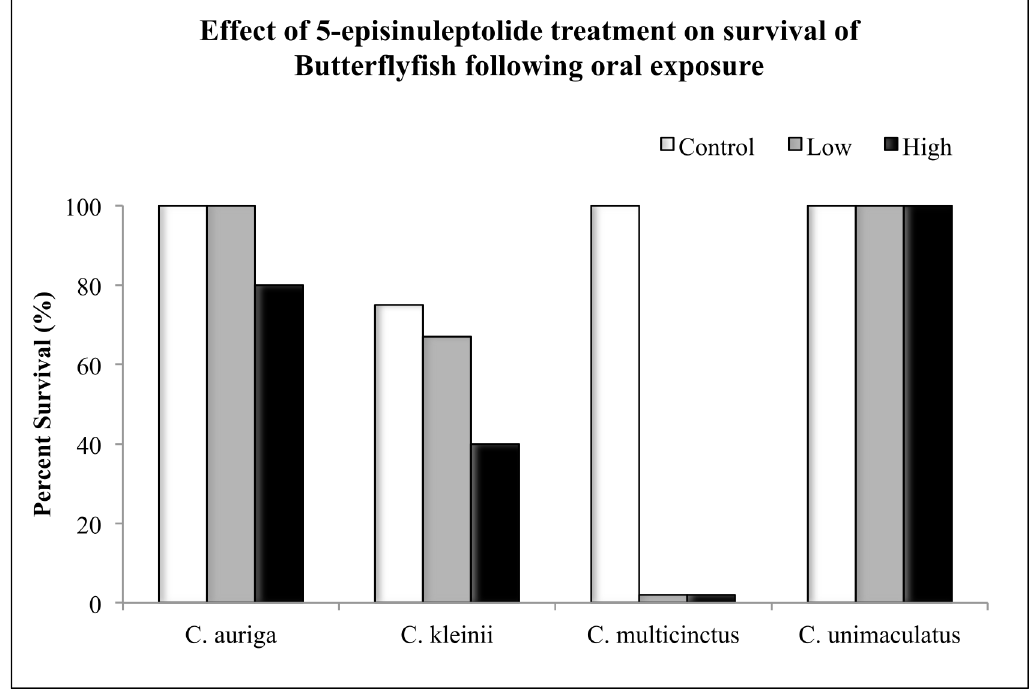
Fig 3. The percentage survival of butterflyfish after a 7 day oral exposure to high dose (3.0mg/kg), or low dose (1.0mg/kg) of 5ESL. Each value represents the total survival of 6 – 8 individuals.